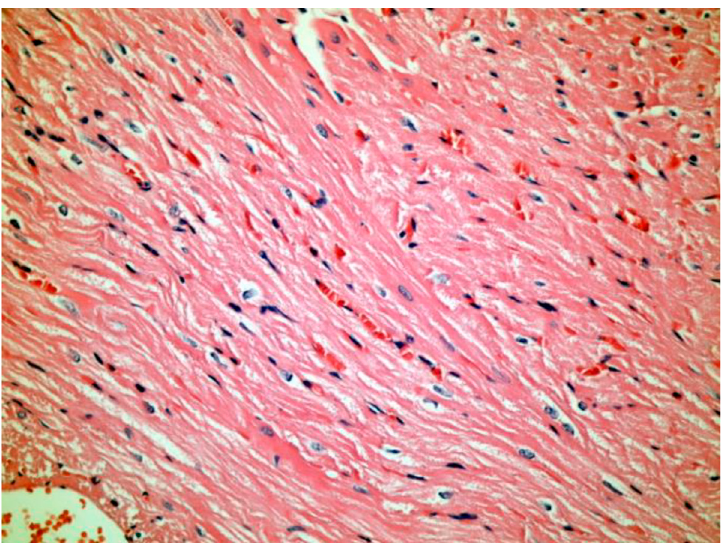
(hematoxylin-eosin × 200).